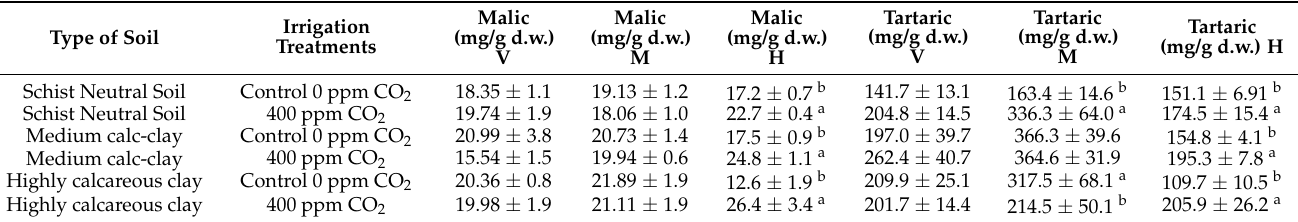
Table 7. Quantitation of malic and tartaric acid in leaves of V. vinifera (L.) cv. Tempranillo, at beginning to ripen (V), maturation (M), and harvest (H). Plants in pots with three different substrates. Treatments: schist soil, medium calcareous clay soil (medium calc-clay), and highly calcareous clay soil, treated with non-acidified water (control pH 7.5) and 400 ppm CO 2 -acidified water (pH 6.5). a,b : different letters denote a statistically significant difference ( p < 0.05) between treatment for